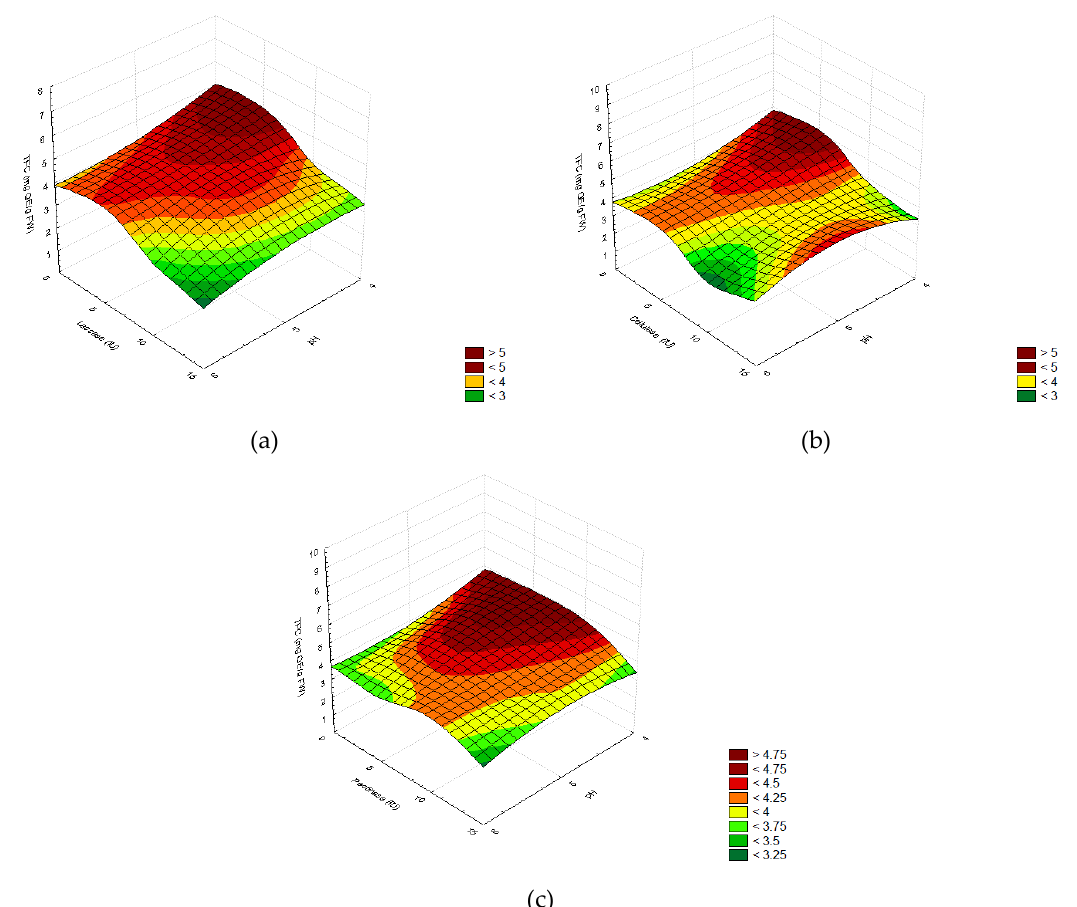
Figure A2. The total flavonoid content (TFC; mg QE/g FW) in the ethanolic extracts plotted as a function of the pH (4 – 6) and individual enzyme concentration (5 – 15 IU), ( a ) cellulase, ( b ) pectinase, ( c ) laccase. The color scale indicates significance of the analysis of variance for the Taguchi method (n = 3, p > 0.05).